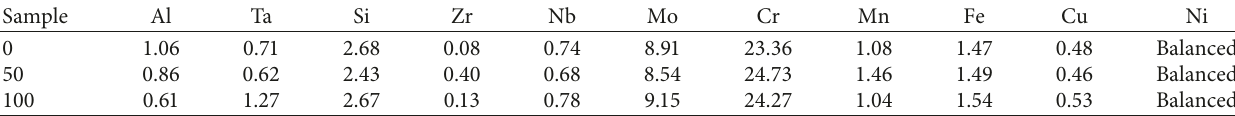
Table 2: The results of chemical composition analyses (%)